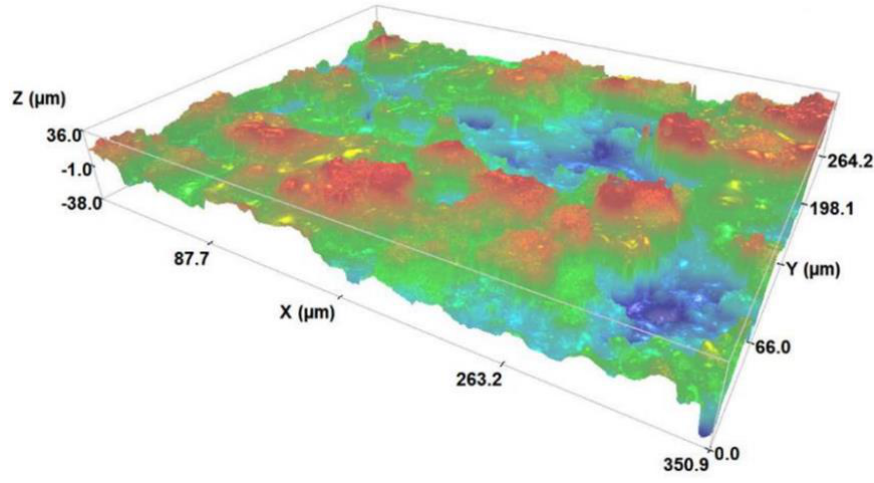
Figure 3. A 3D topographical surface map of an APS Hap coating showing the rough surface of the samples.